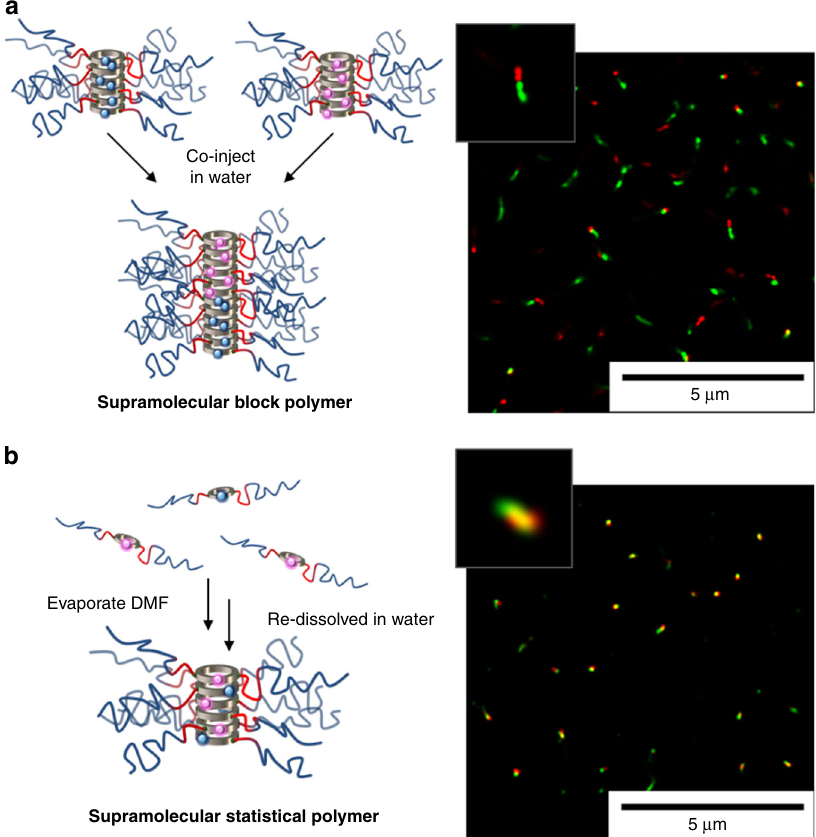
Fig. 5 Composition of cyclic peptide-polymer nanotubes. Schematic and stochastic optical reconstruction microscopy (STORM) of a co-injected and b premixed cyclic peptide-polymer-dye